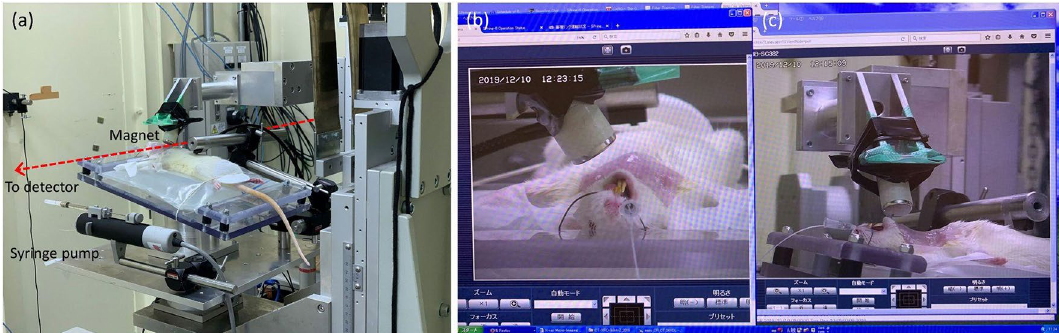
Figure 2. ( a ) in-vivo imaging setup in the SPring-8 imaging hutch, with the path of the X-ray beam marked with a red dashed line. ( b , c ) The magnet positioning over the trachea was performed remotely using two orthogonally mounted IP cameras. On the left-hand side of the screen image the wire loop securing the head, and the delivery cannula in position within the ET tube, can be seen.